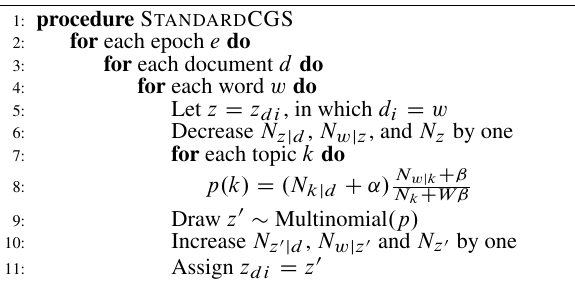
Algorithm 1 Standard serial CGS algorithm.